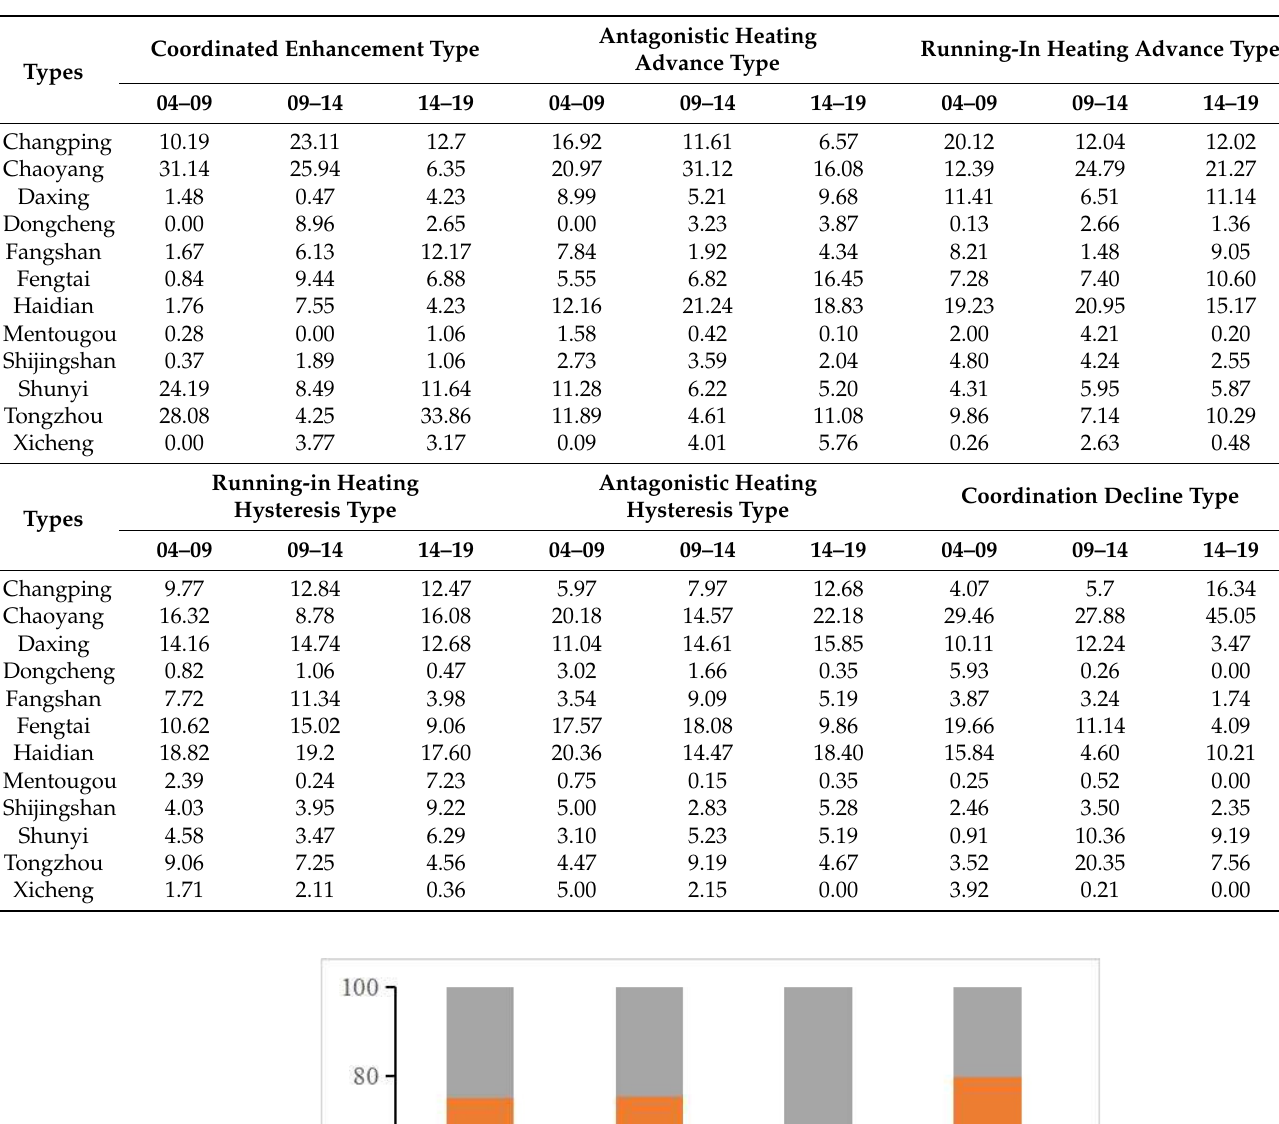
Table 7. Proportions of coordination types between NTL and LST within the sixth ring road of Beijing.